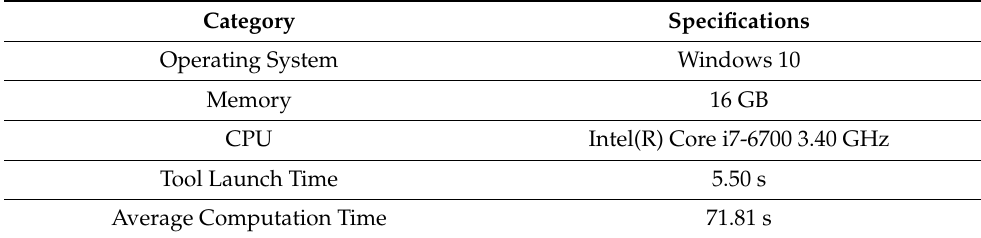
Table 3. Experimental environment of the